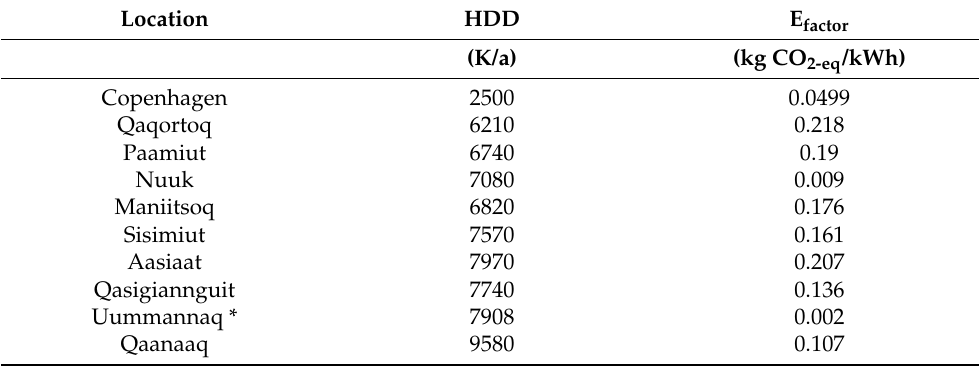
Table 1. HDD and E factor related to district heating for each location represented in the tool [23]. * indicates alternative calculation methods for